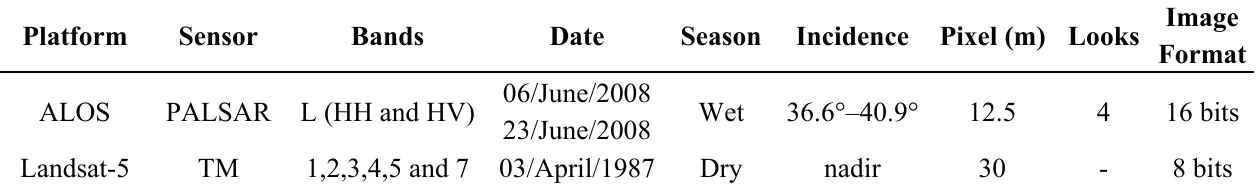
Table 1. Characteristics of the remotely sensed data used in this